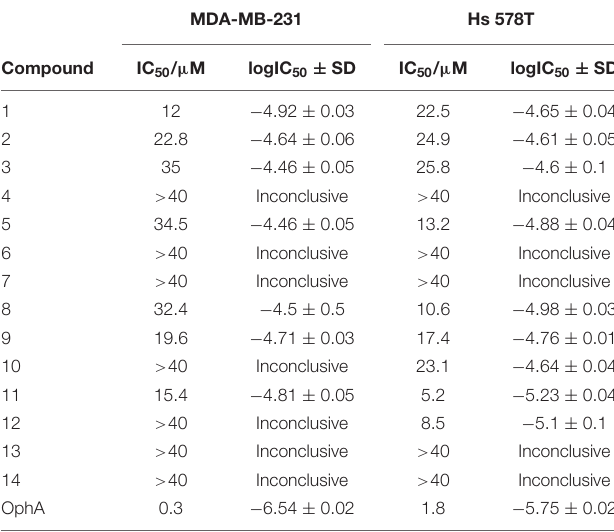
TABLE 1 | IC 50 values of benzazulenones tested on 3D tumorosphere